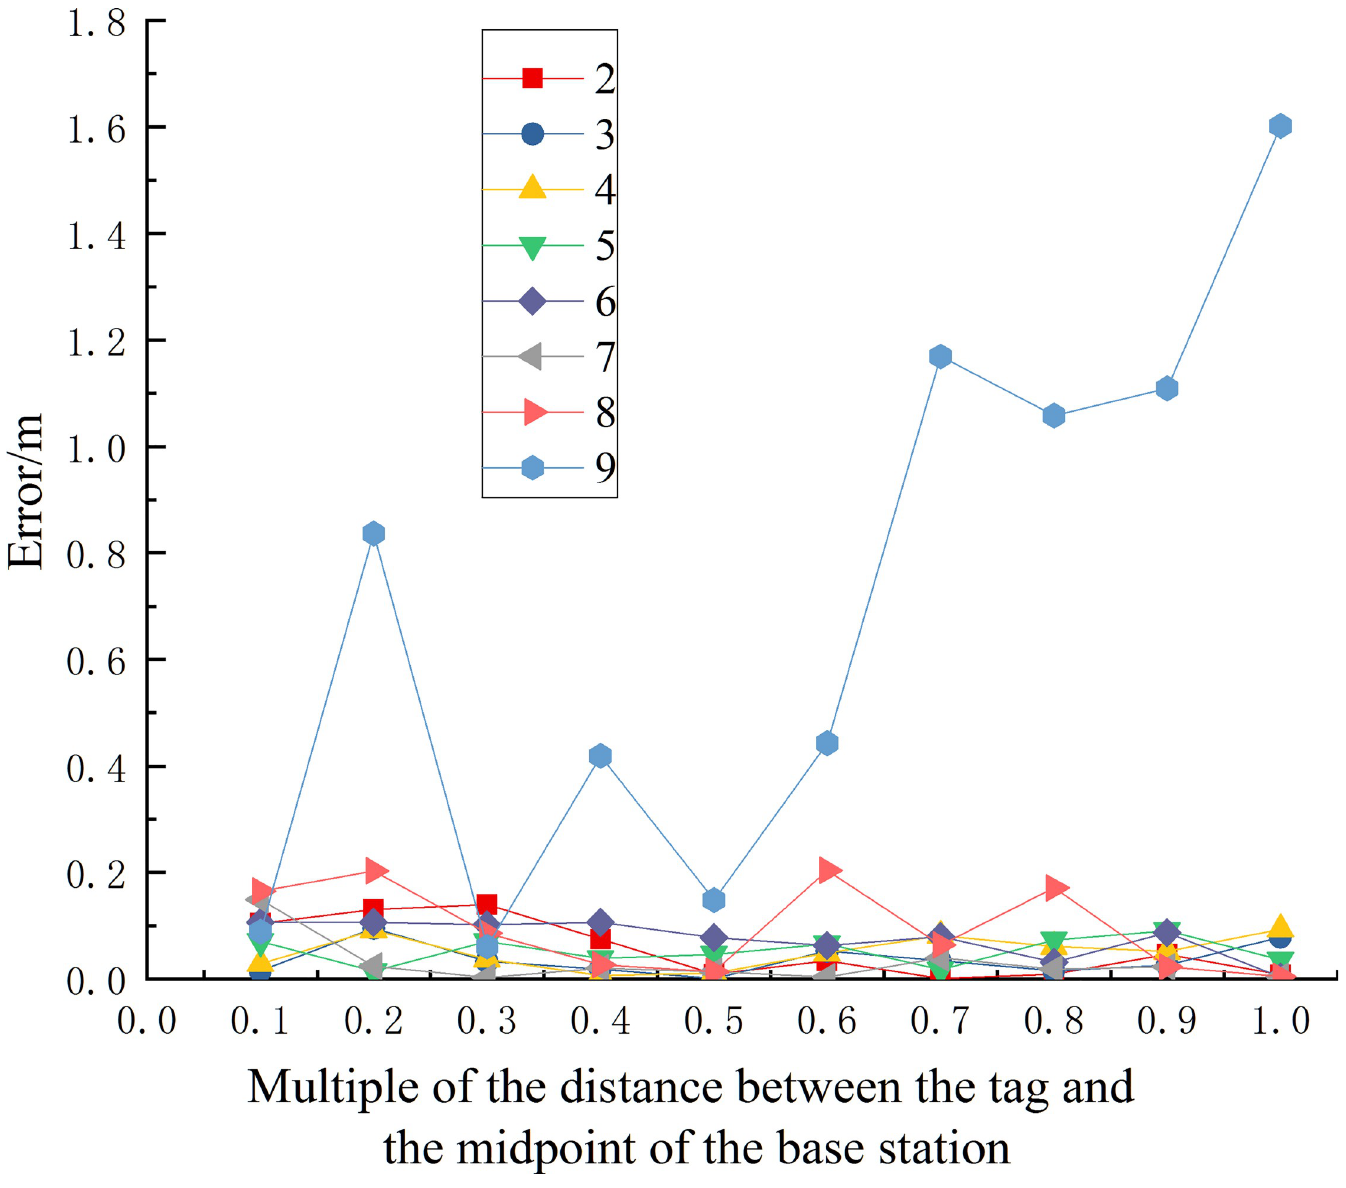
Fig 5. Error in experiments